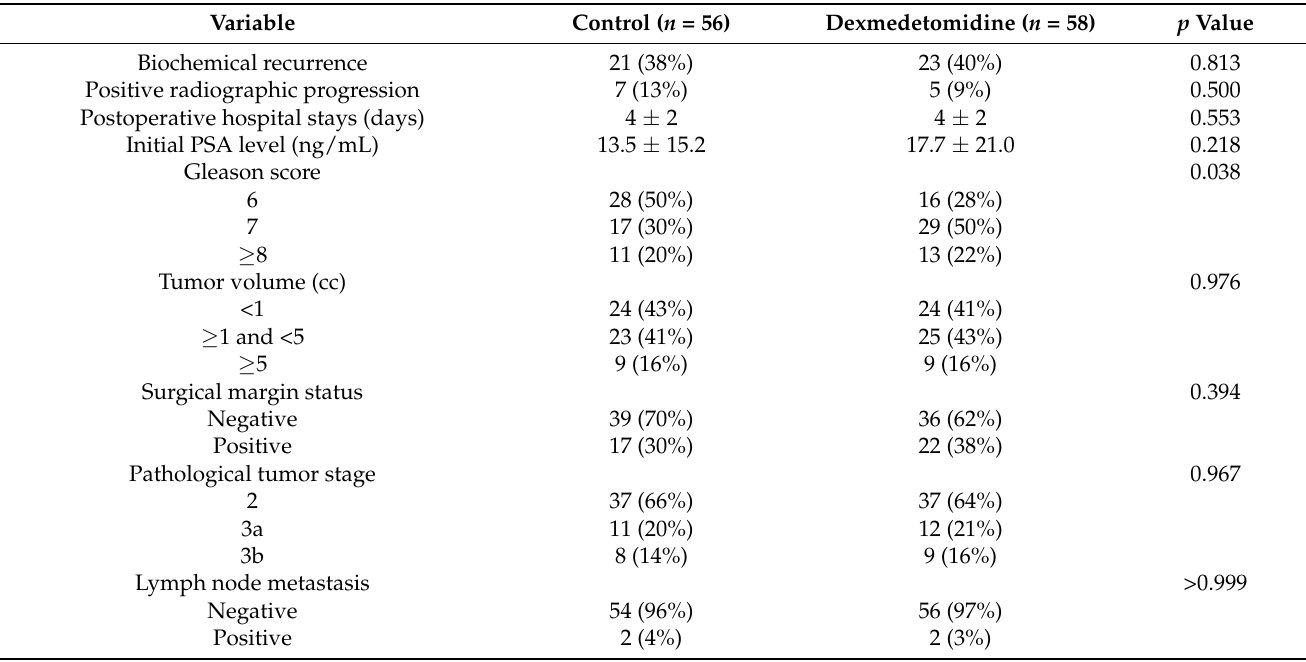
Table 2. Postoperative outcomes and pathological